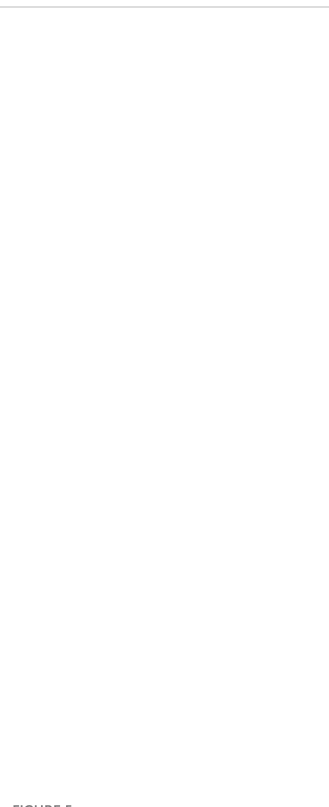
FIGURE 5 Mfn2 overexpression restrain SVV-induced RIG-I/IRF7 protein expression level and IFN- l 3 content in supernatant in PK-15 cells (A) The western blot assay for RIG-I and p-IRF7. (B, C) The relative protein expression level of RIG-I and p-IRF7. (D) The Elisa assay for IFN- l 3 detection. Unpaired T-test and One-way analysis of variance (ANOVA) were used to investigate the signi fi cance of differences. * means the difference between the WT and Ad-Mfn2 in control group; # means the difference between the WT and Ad-Mfn2 in SVV group. *; P < 0.05, ** ,## ; P < 0.01, *** ,### ; P < 0.005, #### ; P < 0.001, ns means no signi fi